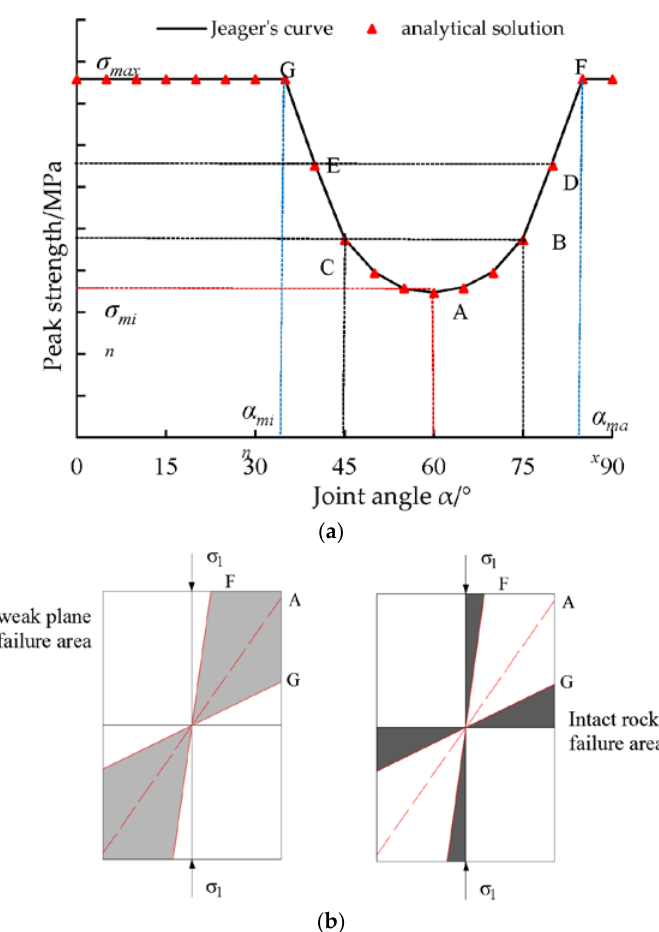
Figure 7. Schematic illustration for rock mass strength anisotropy: ( a ) Jaeger’s curve, ( b ) dominant failure area for weak plane and for rock matrix. Table 1. Selected possible joint strength parameter combinations for two joints (MC model).